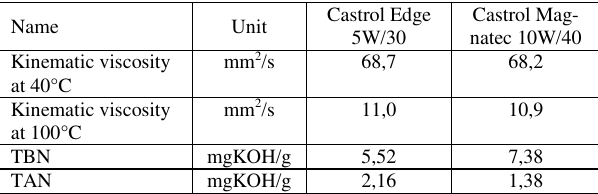
Table 2. The physicochemical properties (as measured) of fresh Castrol Edge 5W/30 and Castrol Magnatec 10W/40 engine oils used in the tests